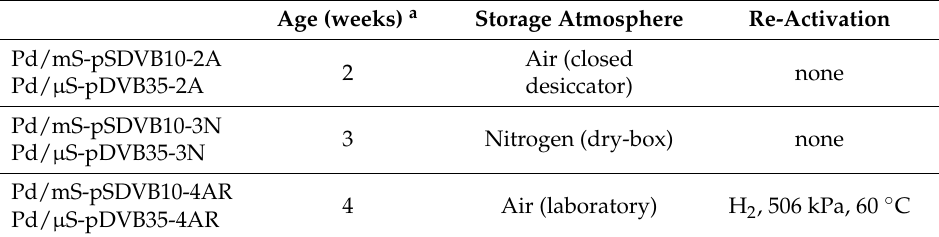
Table 2. History and coding of the catalysts’ leftovers tested after ageing.